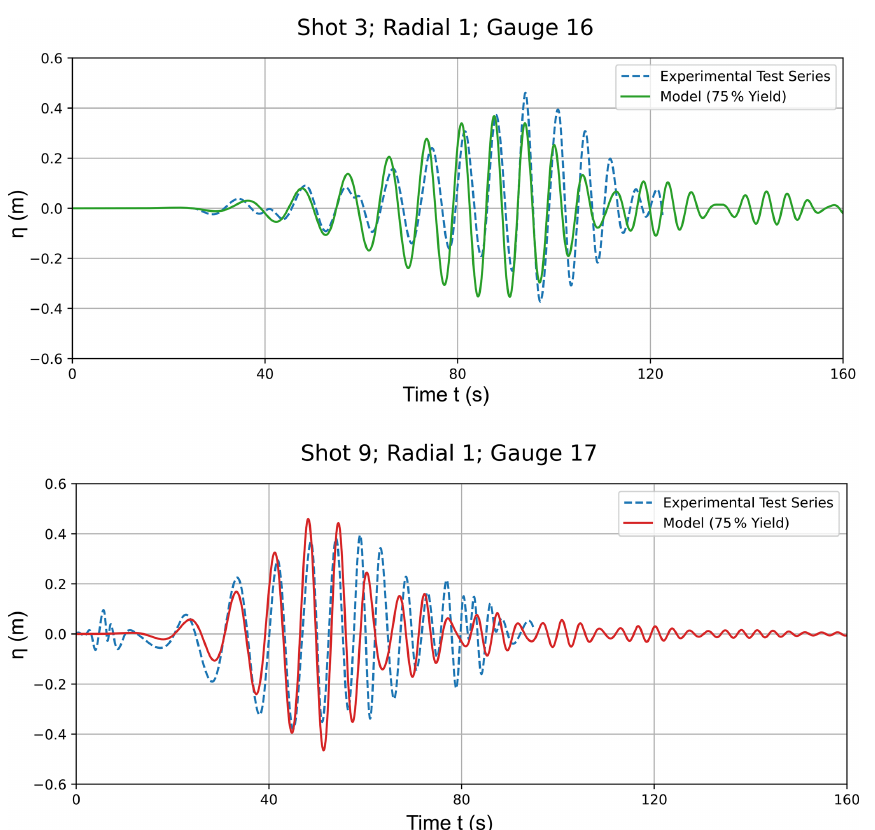
Figure 7. Time series comparison at closest gauge to GZ for both considered shots.